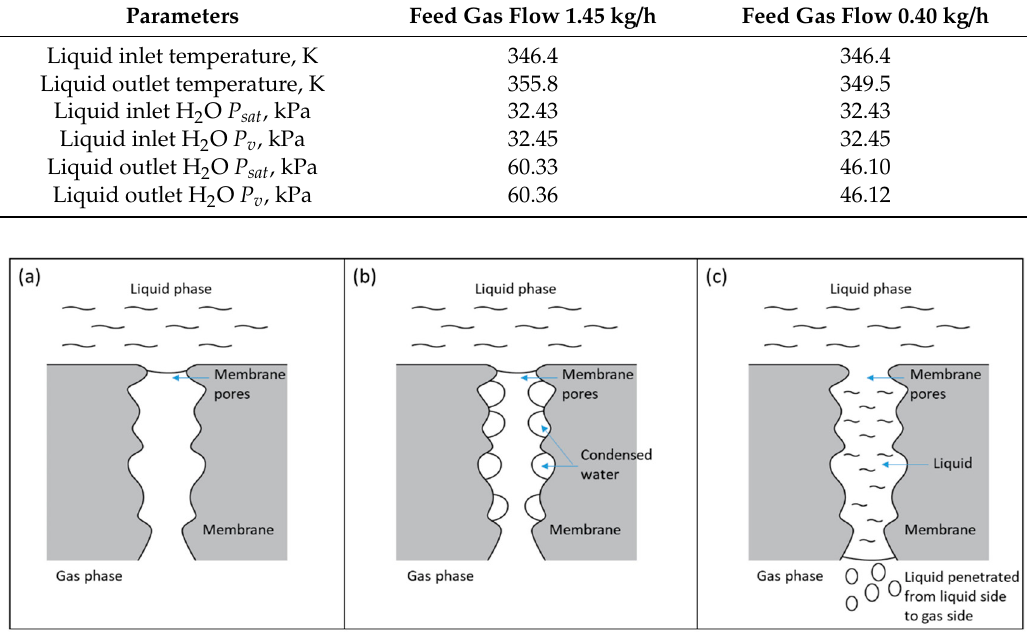
Figure 4. Membrane wetting mechanism caused by water condensation. ( a ) Dry membrane pores. ( b ) Membrane pores with condensed water droplets. ( c ) Membrane pores fully filled with condensed water and formed a liquid bridge for a liquid to go into the gas side of the hollow fiber membranes.